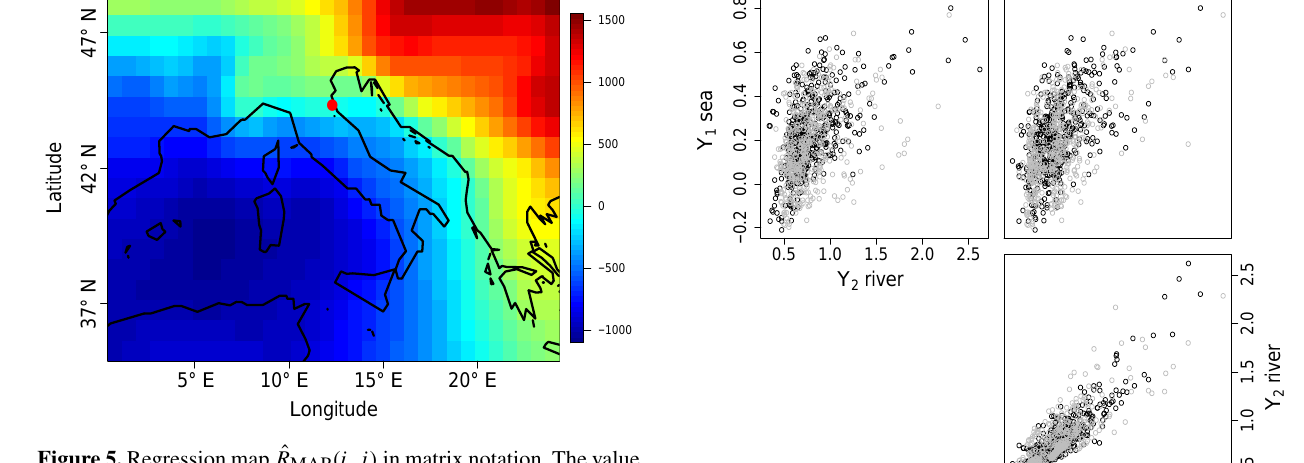
Figure 5. Regression map ˆ R MAP (i,j) in matrix notation. The value of the regression map in the location (i,j) is given by ˆ R MAP (i,j) = var (R 0 ) − 1 × cov (R 0 , SLP i,j ) , where R 0 (t) is the residual of the barometric pressure effect obtained from the fit of the linear model a 0 SLP Ravenna (t) + d 0 to Y 1 (t) . The regression map is equiva- Sea Figure 6. Scatter plots of observed (grey) against simulated (black) lent to a one-dimensional maximum covariance analysis (Widmann, contributing variables Y . The simulated series are obtained via the 2005). The red dot indicates Ravenna. three-dimensional model (including the serial correlation), and have the same length as the observed